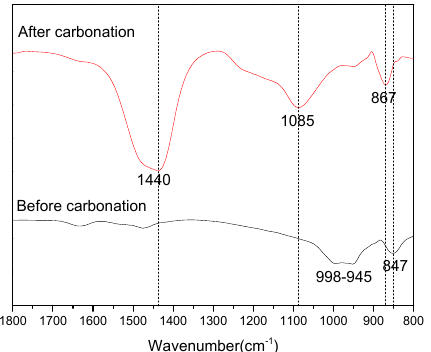
Figure 3. Fourier Transform-Infrared (FT-IR) spectrums of the C 3 S 2 phase before carbonation and carbonated for 24 h.